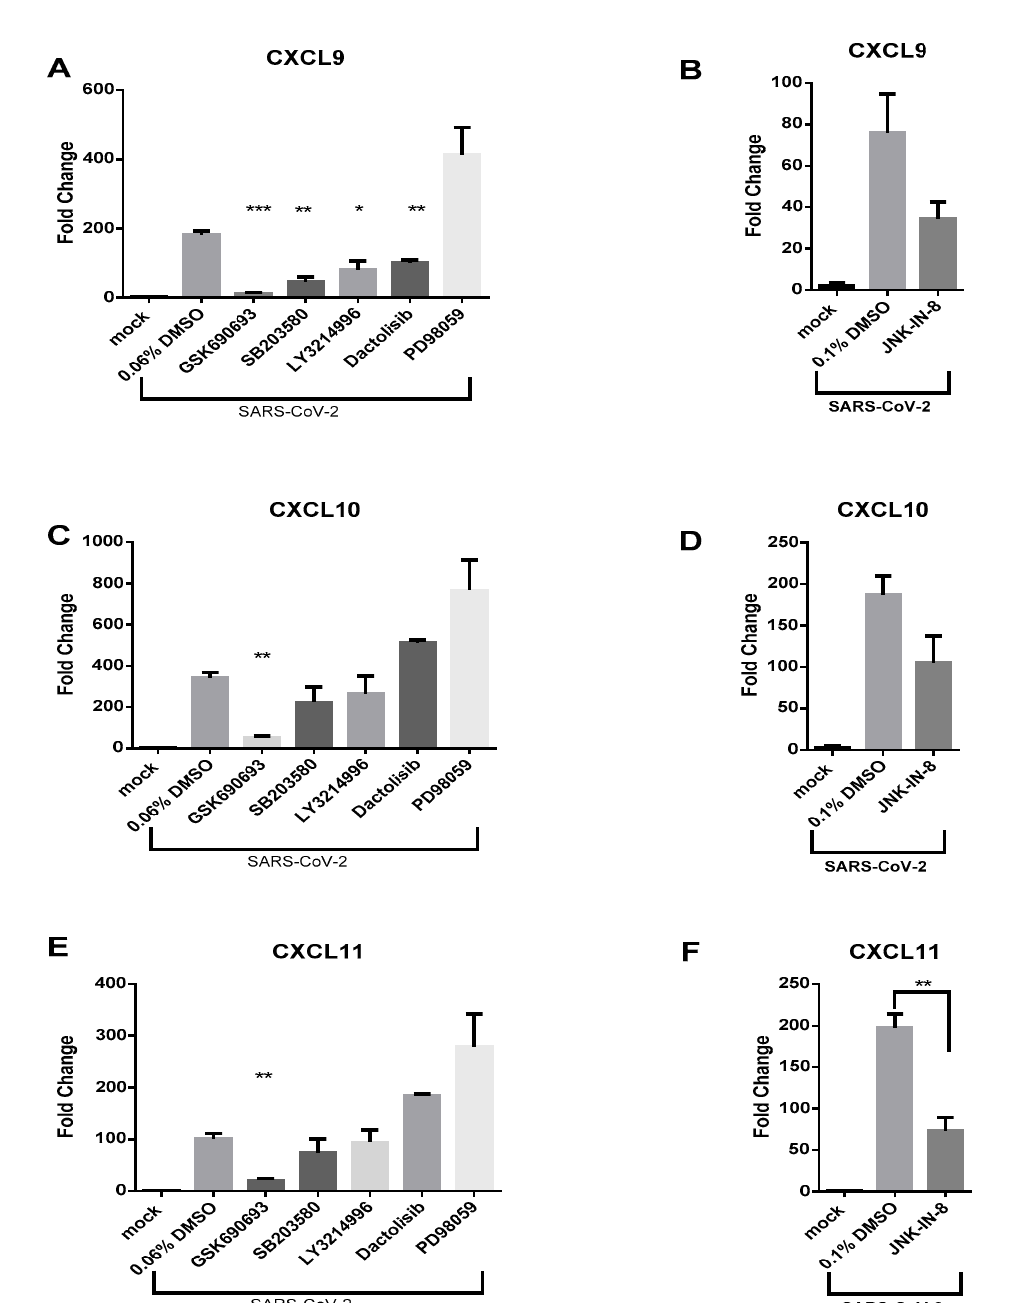
Figure 5. The inhibition of AKT prevents CXCL9, CXCL10, and CXCL11 chemokine induction by SARS-CoV-2. RNA samples generated as described in Figure 4 were subjected to RT-qPCR analysis of CXCL9 ( A , B ), CXCL10 ( C , D ), and CXCL11 ( E , F ) gene expression. Transcript levels are expressed as fold change compared to infected cells exposed to vehicle alone and represent the mean ± SEM ( n = 3). Significance was determined using the Student’s t -test; * p < 0.05, ** p < 0.001, *** p < 0.0001.